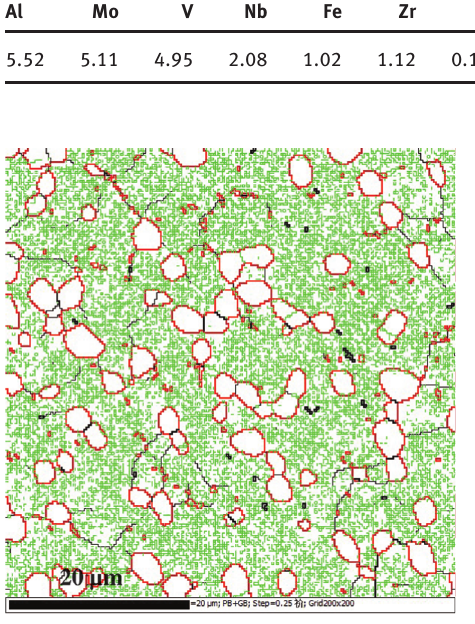
Figure 2: EBSD map showing the microstructure of the initial Ti555211